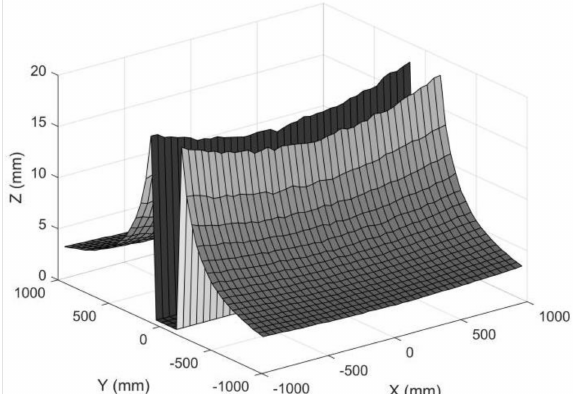
Figure 18. Standard deviation for object points in a plane. The standard deviations for object points with small Y C coordinates were removed for large reconstruction errors. The standard deviation of the pixel position was 0.2 pixels, the ad was 100 mm, and the Z C was 1500